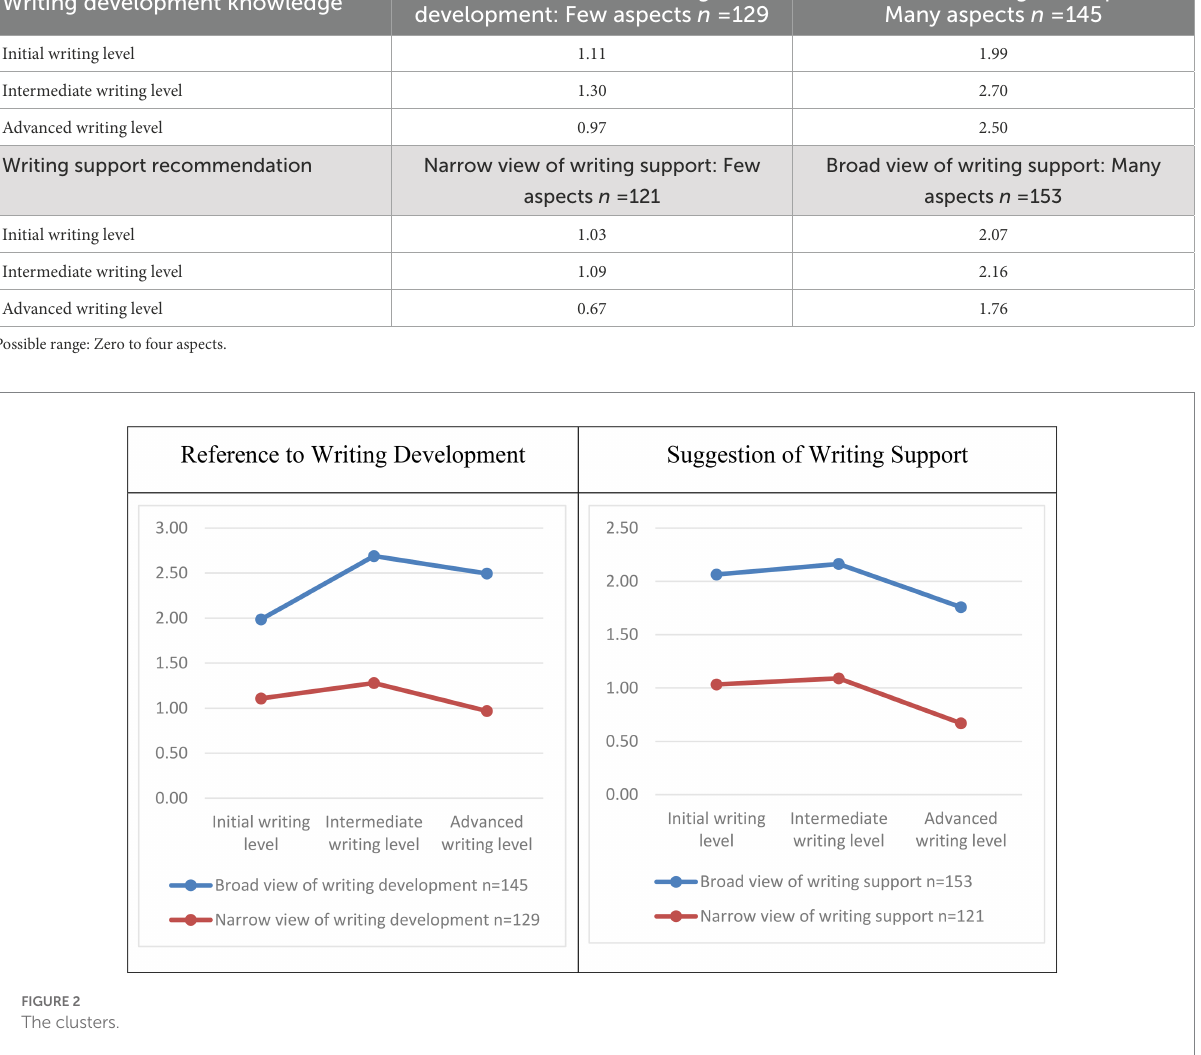
TABLE 4 Classification of parents’ views according to their complexity scores into clusters: Narrow and broad view of writing development and writing support 1 ( N = 274). Writing development